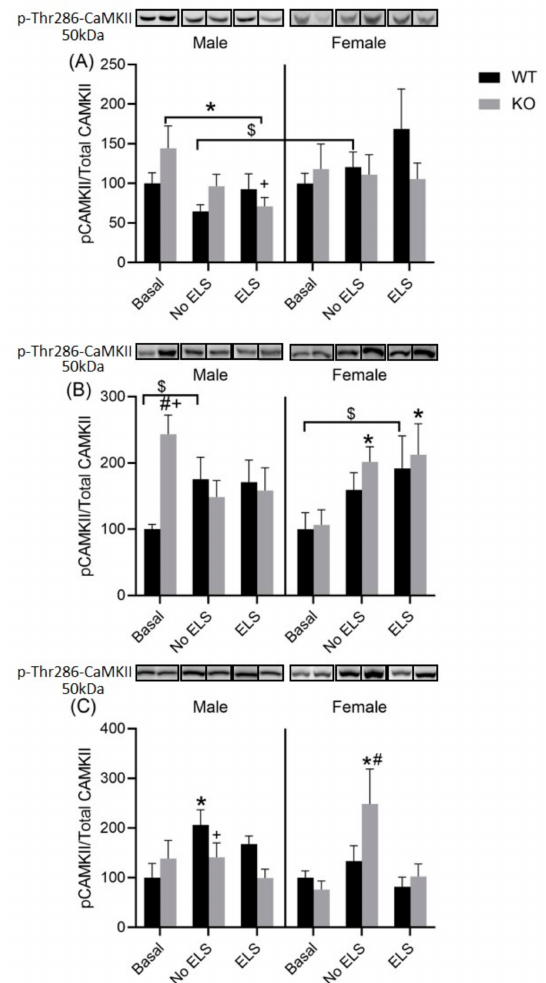
Figure 8. Effect of early life stress in WT and GPR37KO mice on the expression of P-T286- CaMKII/total CaMKII in the dorsal hippocampus ( A ); WT basal male = 6, WT no-ELS male = 7, WT ELS male = 6, KO basal male = 7, KO no-ELS male = 7, KO ELS male = 6, WT basal female = 6, WT no-ELS female = 6, WT ELS female = 6, KO basal female = 6, KO no-ELS female = 6 and KO ELS female = 6. Ventral hippocampus.( B ); WT basal male = 6, WT no-ELS male = 6, WT ELS male = 7, KO basal male = 7, KO no-ELS male = 7, KO ELS male = 6, WT basal female = 6, WT no-ELS female = 6, WT ELS female = 5, KO basal female = 6, KO no-ELS female = 6 and KO ELS female = 6 and amyg- dala ( C ) WT basal male = 6, WT no-ELS male = 7, WT ELS male = 6, KO basal male = 7, KO no-ELS male = 6, KO ELS male = 5, WT basal female = 7, WT no-ELS female = 7, WT ELS female = 5, KO basal female = 6, KO no-ELS female = 8 and KO ELS female = 5 All data represent mean ± SEM. * p < 0.05 versus corresponding WT; # p <0.05, treatment difference within genotype; + p < 0.05, with respect to sex; $ p > 0.05 < 0.1 calculated by three-way ANOVA followed by multiple